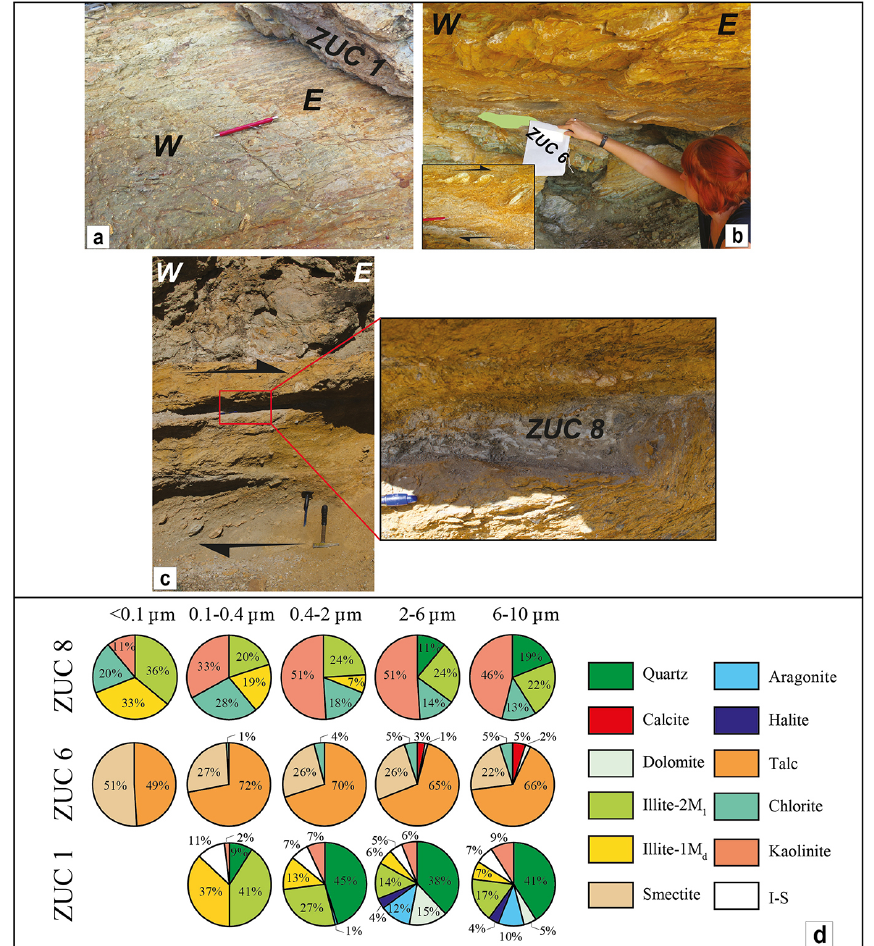
Figure 7. (a–c) Sampled fault rocks and associated mesoscopic structures. ZUC 1 is from BSF 1 and comes from the immediate hanging wall of the ZF principal slip surface, which is decorated by pervasive E–W striae. ZUC 6 is from the uppermost part of BSF 3, which contains very clear top-to-the-east kinematic indicators. ZUC 8 is from the easternmost exposed BSF 1, where clear top-to-the-east kinematic indicators occur. (d) Mineralogical composition of the separated grain size fractions of the three dated